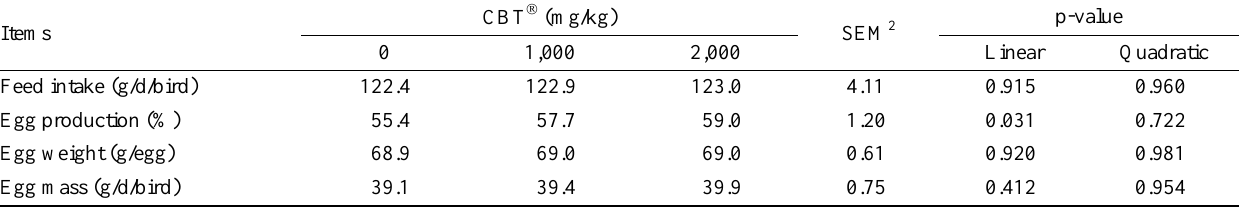
Table 2. Effects of dietary CBT  supplementation on feed intake and production performance in laying hens 1